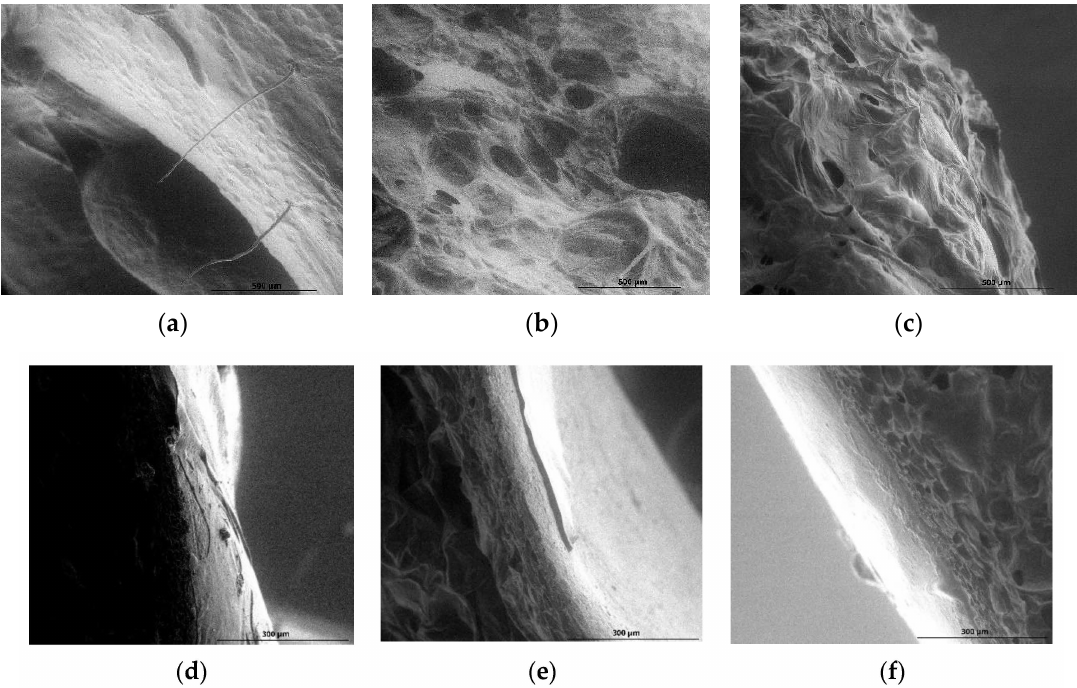
Figure 2. Scanning electron microscopy (SEM) images of ( a ) strawberry coated with medium molec- ular weight chitosan, acetic acid, and grape seed EO (magnification 500 × ); ( b ) strawberry coated with medium molecular weight chitosan, acetic acid, and sea buckthorn EO; ( c ) strawberry coated with high molecular weight chitosan, ascorbic acid, and grape seed EO; ( d ) apple slices coated with medium molecular weight chitosan, acetic acid, and grape seed EO (magnification 500 × ); ( e ) apple slices coated with medium molecular weight chitosan, acetic acid, and sea buckthorn EO; and ( f ) apple slices coated with high molecular weight chitosan, ascorbic acid, and grape seed